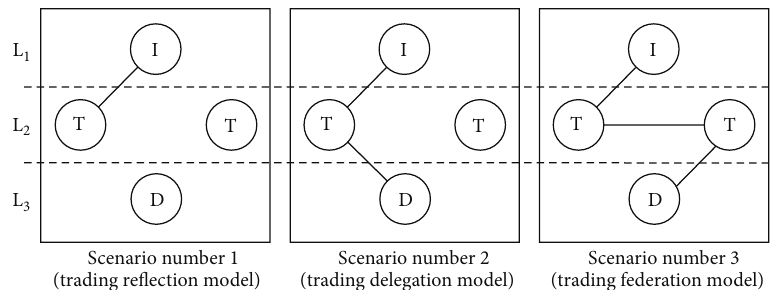
Figure 8: The three trading models of OntoTrader